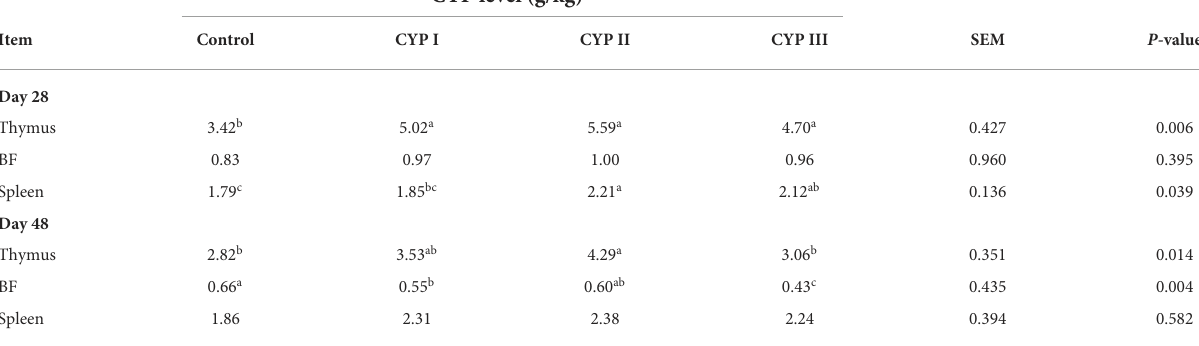
TABLE 2 Effects of CYP on the immune organ index in broilers (g/kg).